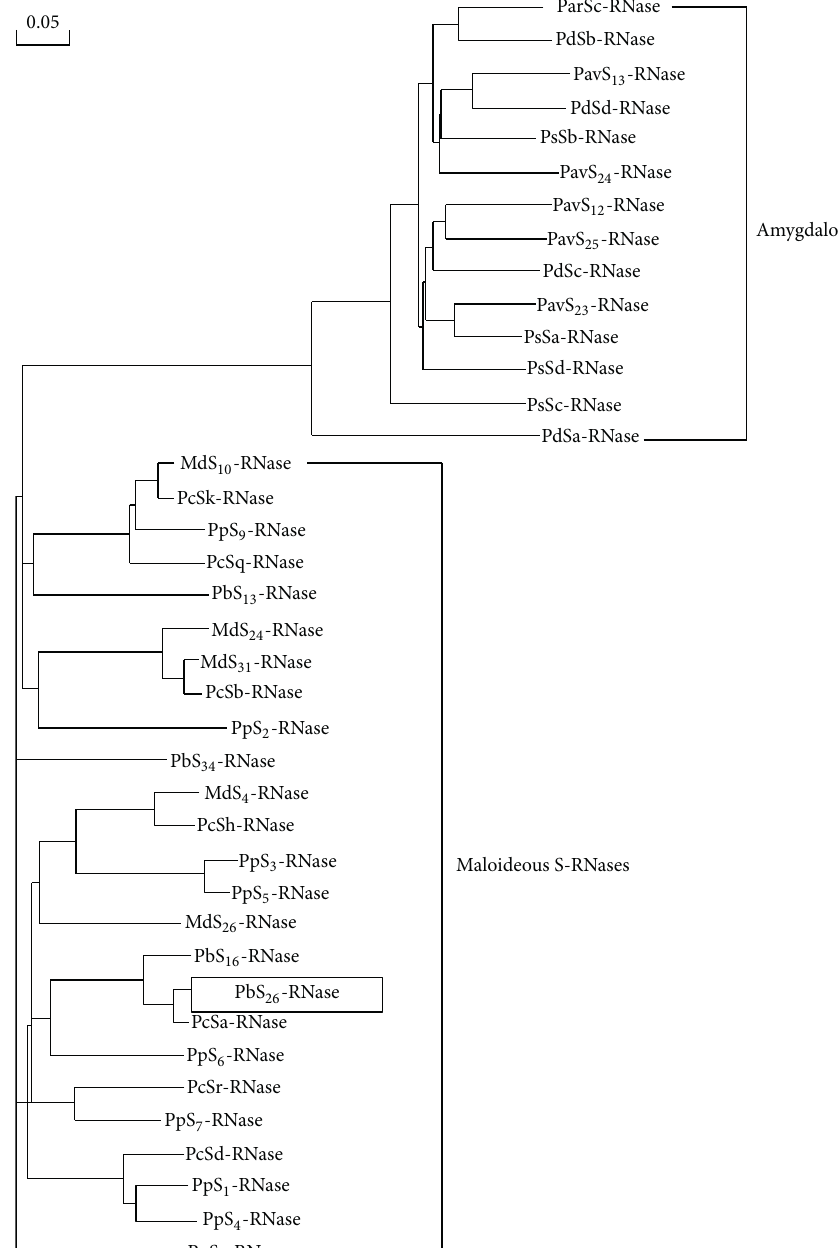
Figure 3: Phylogenetic analysis of the members of S-RNase genes in rosaceous plants. The PbS